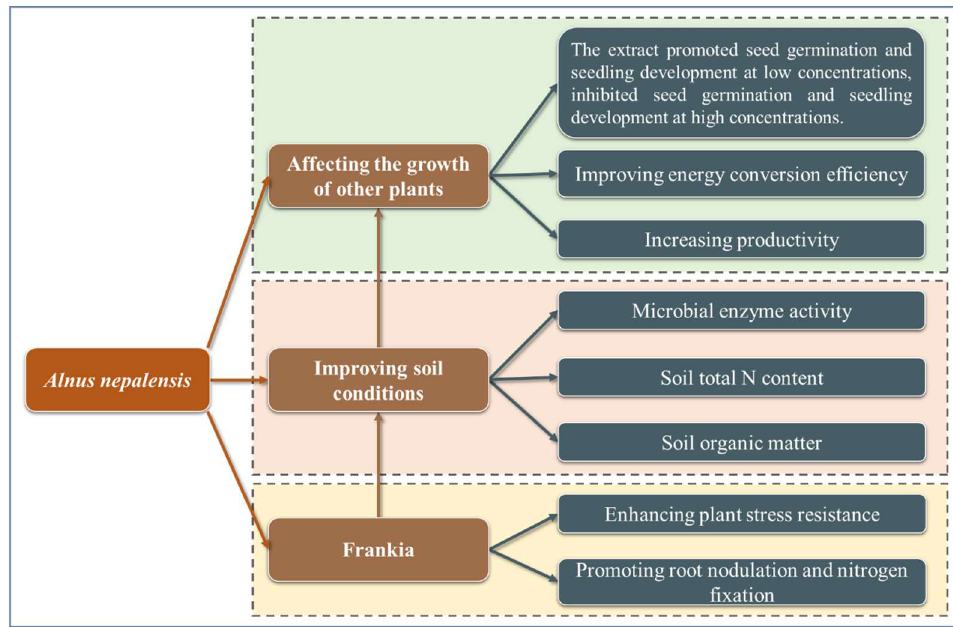
Figure 6. A framework for physio-ecological characteristics and ecological functions of Nepalese